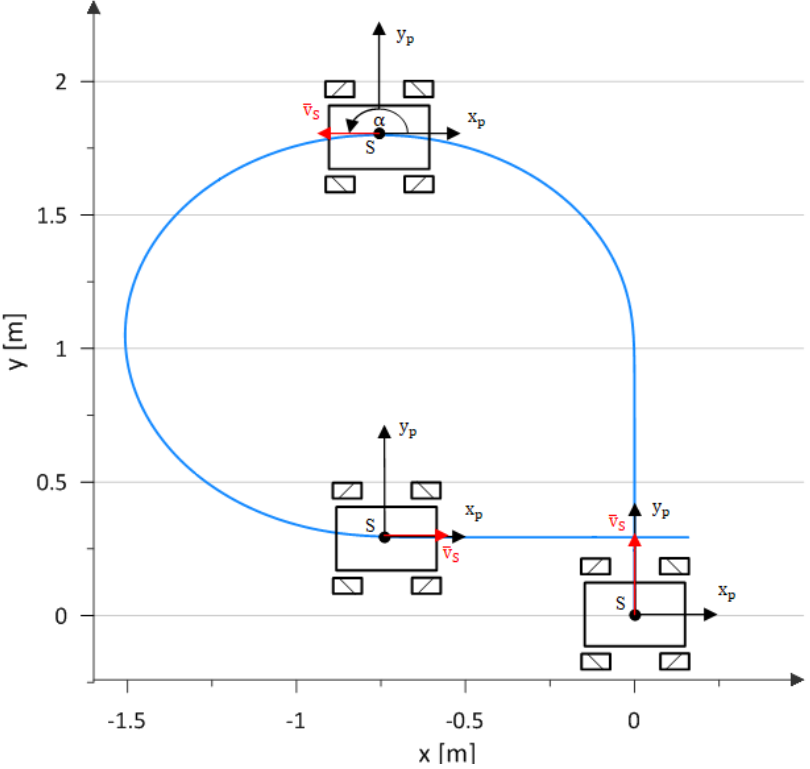
Figure 4. The desired path of point S of the mobile robot ’ s frame.